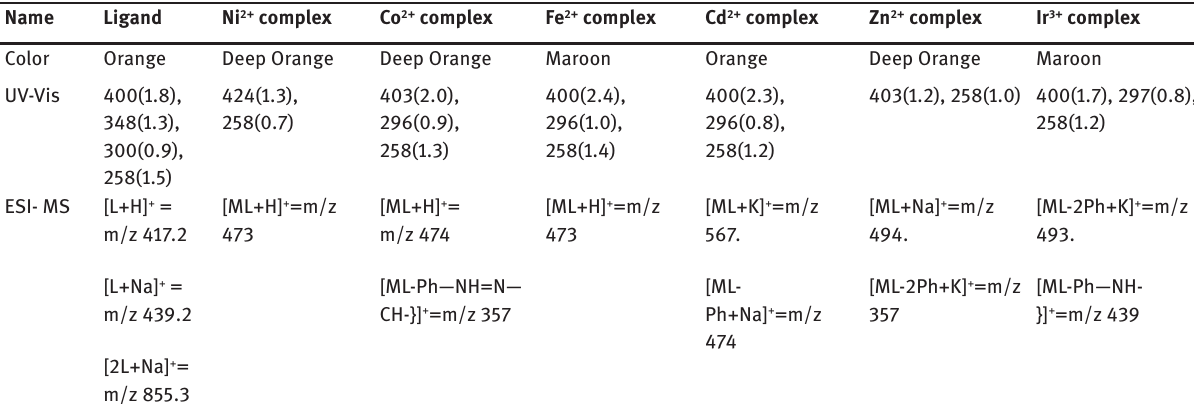
Table 1: Comparative UV-Vis, IR and MS of L and its complexes.